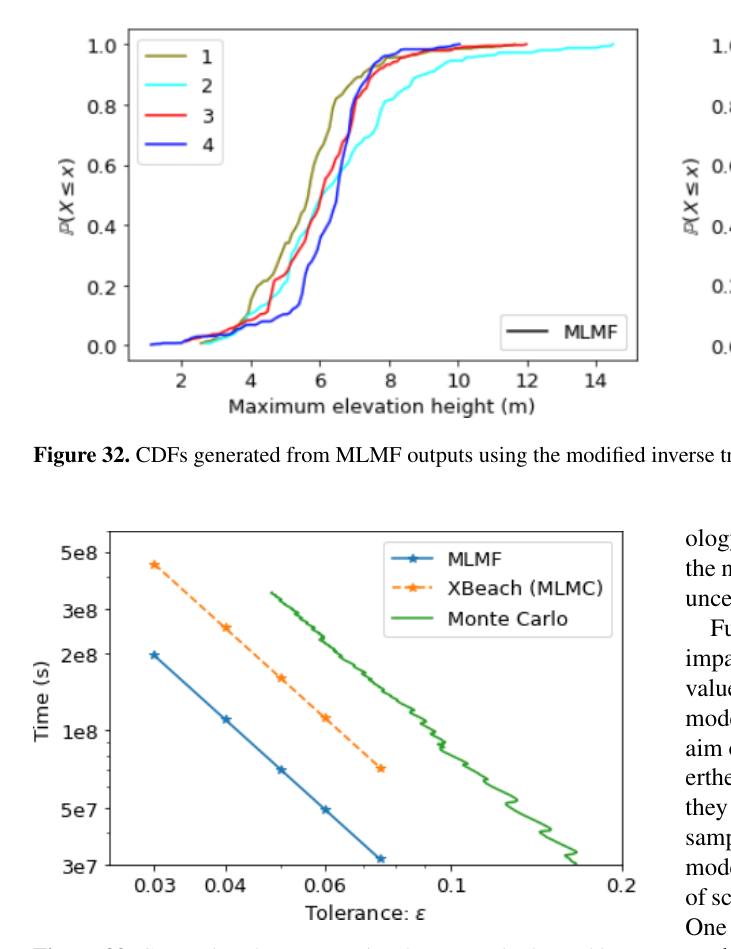
Figure 33. Comparing the computational cost required to achieve tolerance (cid:15) at all locations using MLMF, XBeach with MLMC and Monte Carlo for the Myrtle Beach test